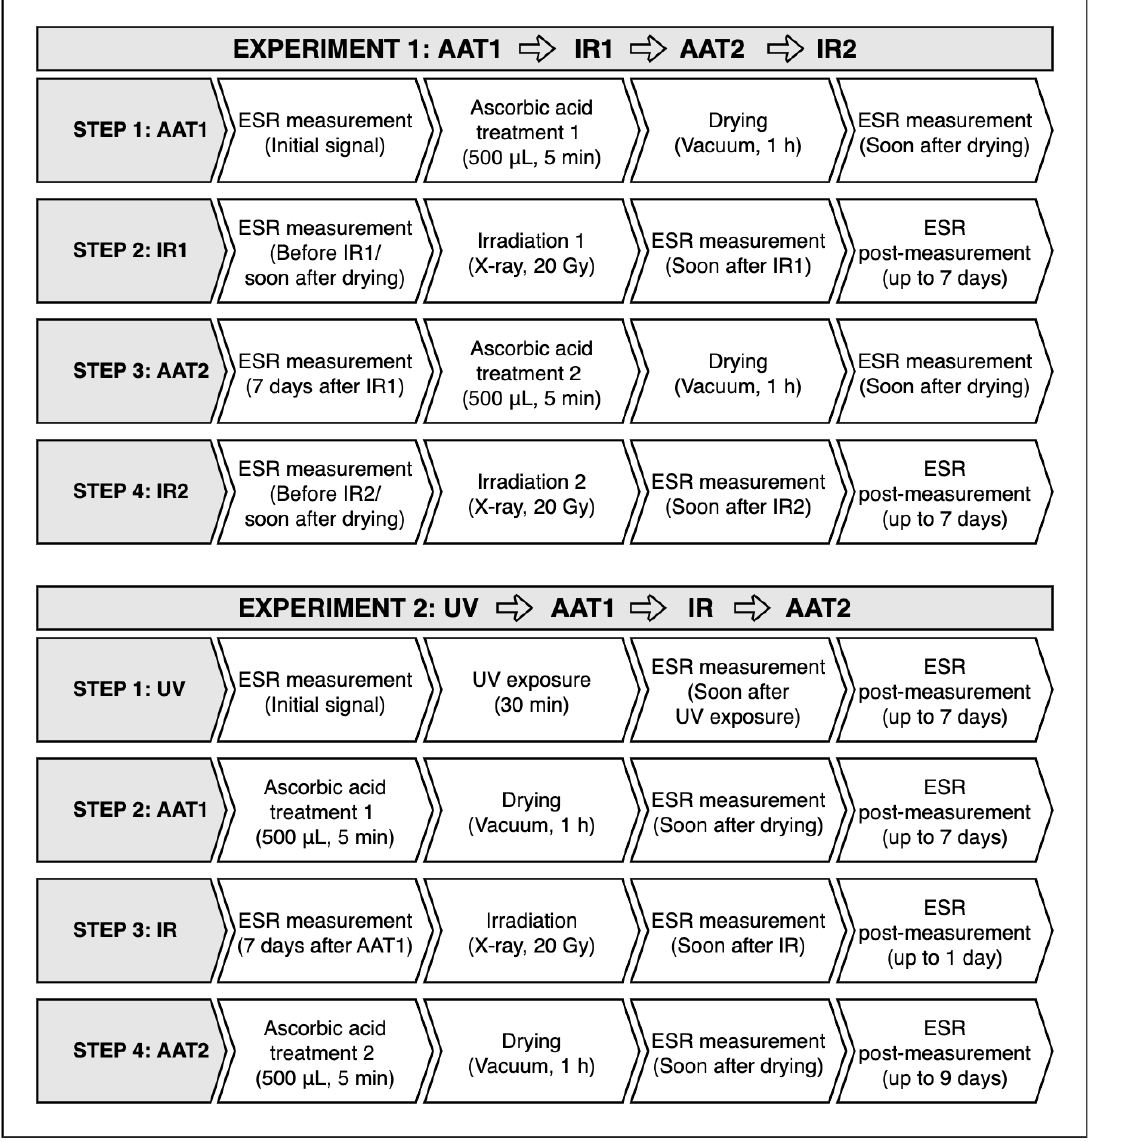
Figure 1. Flow diagram for the specific steps used for Experiments 1 ( above ) and 2 ( below ). The notations UV, AAT, and IR represent ultraviolet, L(+)-ascorbic acid treatment, and irradiation, respectively.